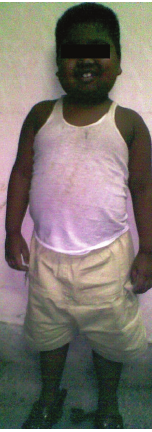
Figure 1: Typical appearance of Cushings syndrome (note moon face and abdominal distension).